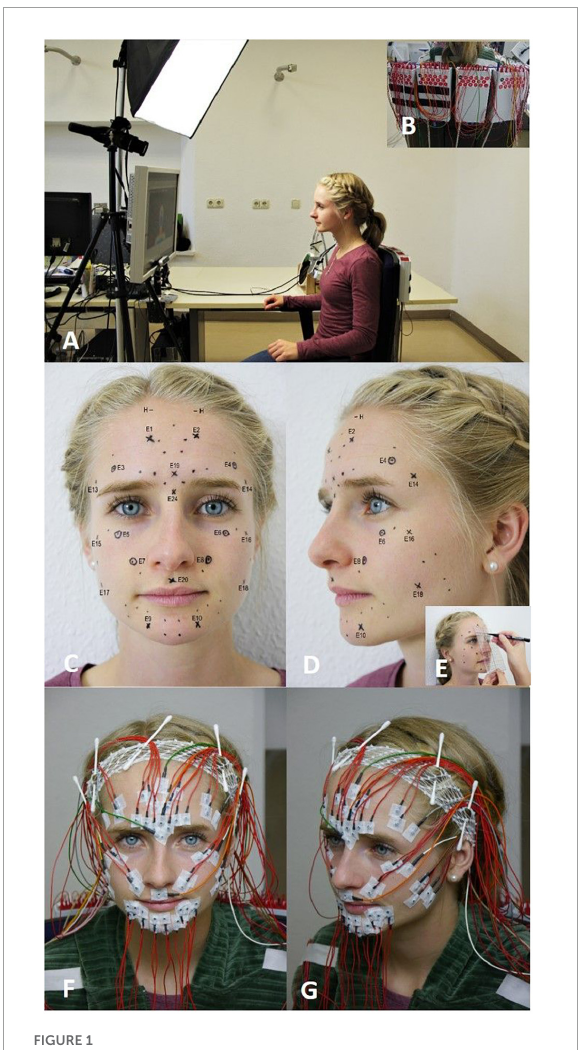
FIGURE1 The experimental setup. (A) The participant is sitting at a standardized distance from the computer screen and is following the instructions. (B) The electromyography (EMG) amplifiers are placed in the back of the chair. (C–E) EMG electrode schemes after Fridlund and Cacioppo (dots) and after (Kuramoto et al., 2019) (crosses) are marked in the face of the participant with the help of a standardized template (circled crosses refer to electrodes shared by both schemes). (F) Frontal view on the fixed surface EMG (sEMG) electrodes. (G) Side view on the fixed sEMG